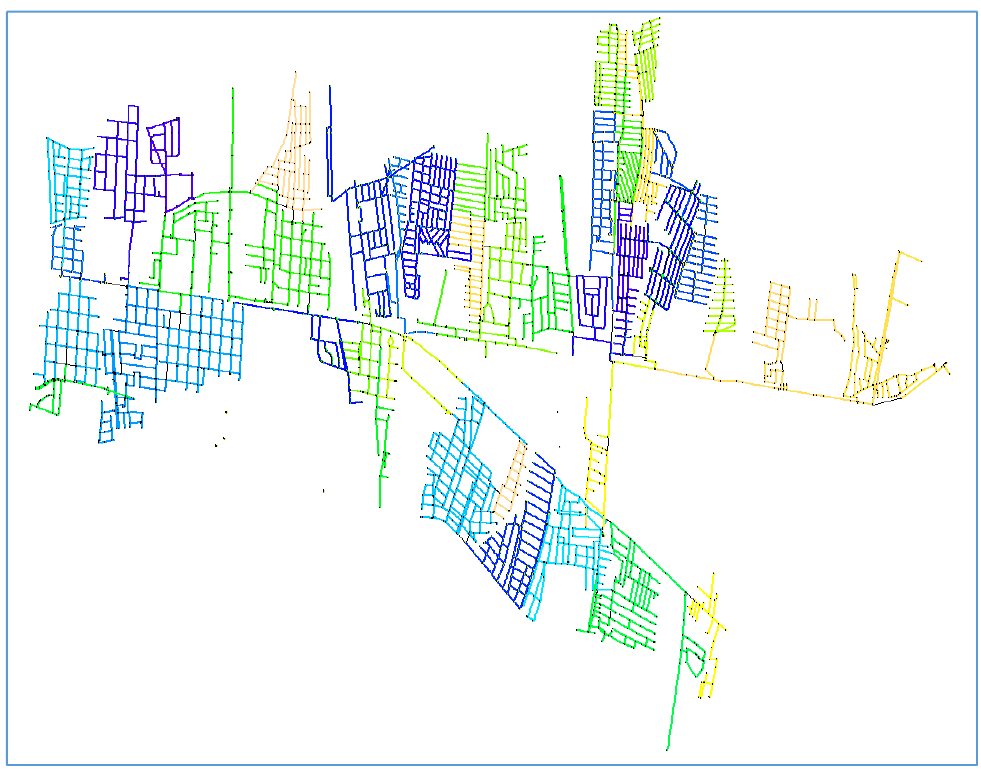
Figure 4. Layout with maximum elevation difference constraint set at 20 m.